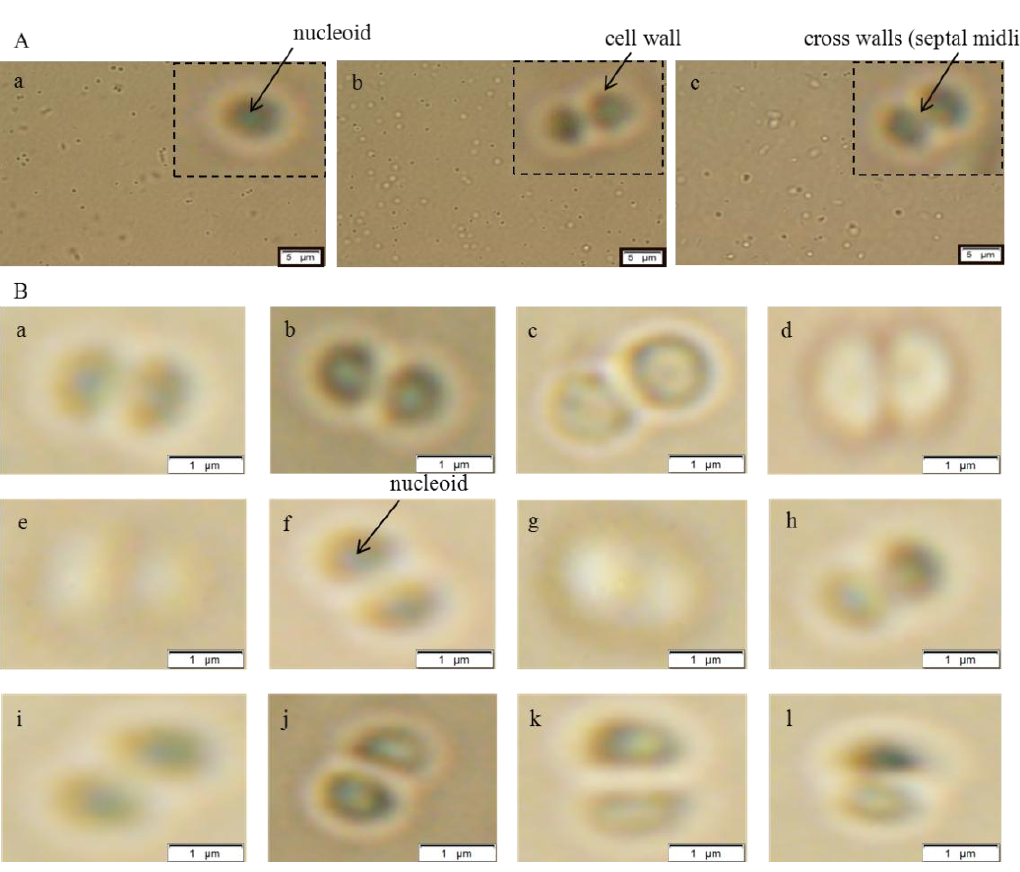
Figure 1. Images of S. aureus cells using microscopy in ambient light: ( A ) Micrographs of cells with resistance to metal ions ( a ) non-resistant strain of S. aureus ; ( b ) RCd; ( c ) RPb. Parameters were as follows: Device: Microscopy; Volume: 5 μL; Zoom: 1600×; Ambient light; Exp.t.: 32.05 ms; ISO 200; Resolution: 4800 × 3600. ( B ) Micrographs of cells with resistance to metal ions after the application of antibiotics (50 µM): ( a )